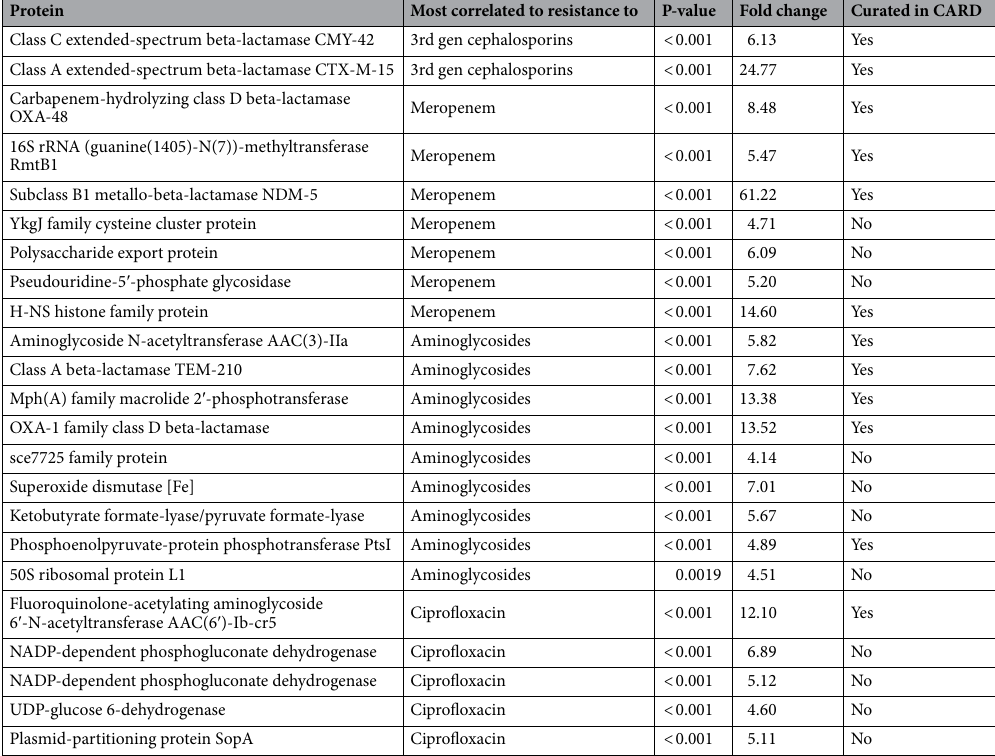
Table 5. All protein groups which were more than four times as abundant in resistant E. coli isolates compared to susceptible E. coli